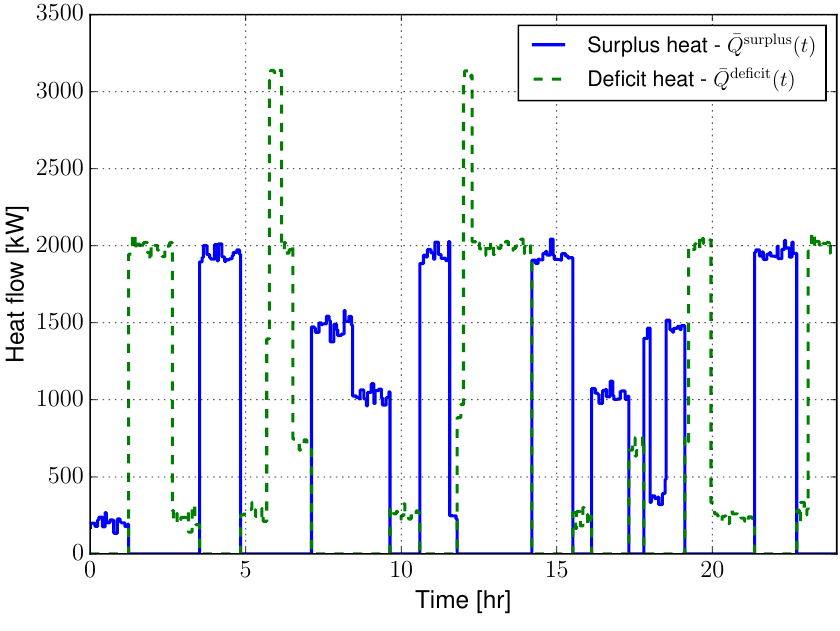
Figure 6. The time-varying total surplus and deficit heat for the industry cluster case study.